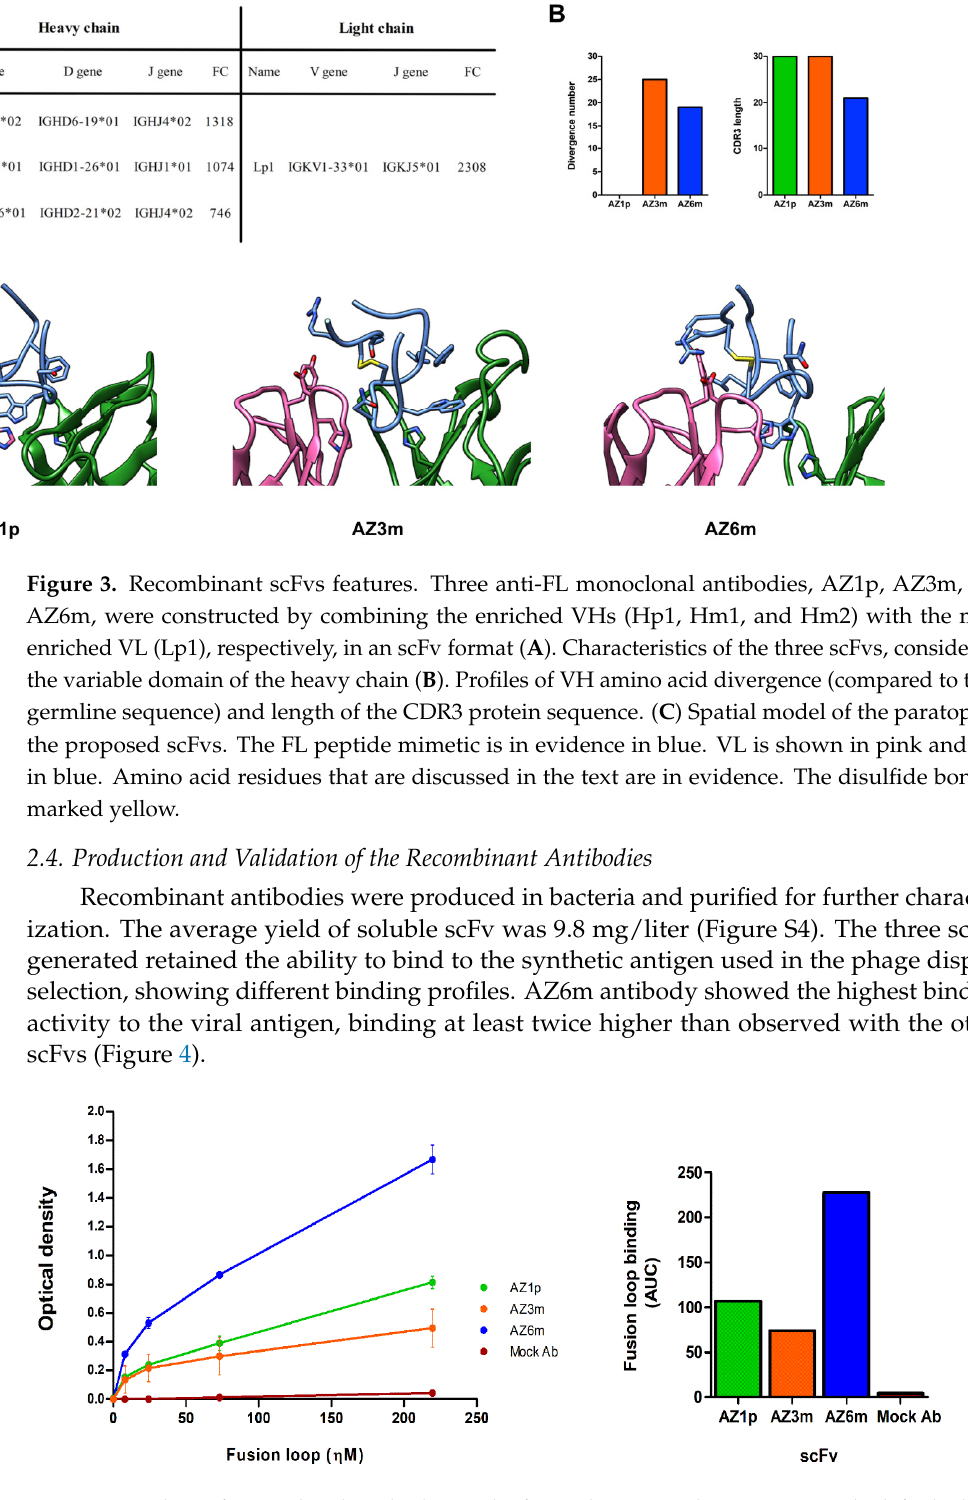
Figure 4. Binding of monoclonal antibodies to the fusion loop peptide mimetic. On the left, the binding of the recombinant scFvs to the fusion loop used in the selection was analyzed by immunoassay (ELISA). The normalized area under curve for each antibody FL binding is on the right. Data are presented as mean +/− SD and correspond to two independent experiments, with antibodies from different preparation batches. An unspecific scFv, produced in the same conditions as the anti-FL scFvs, was used as a negative antibody (Mock Ab).